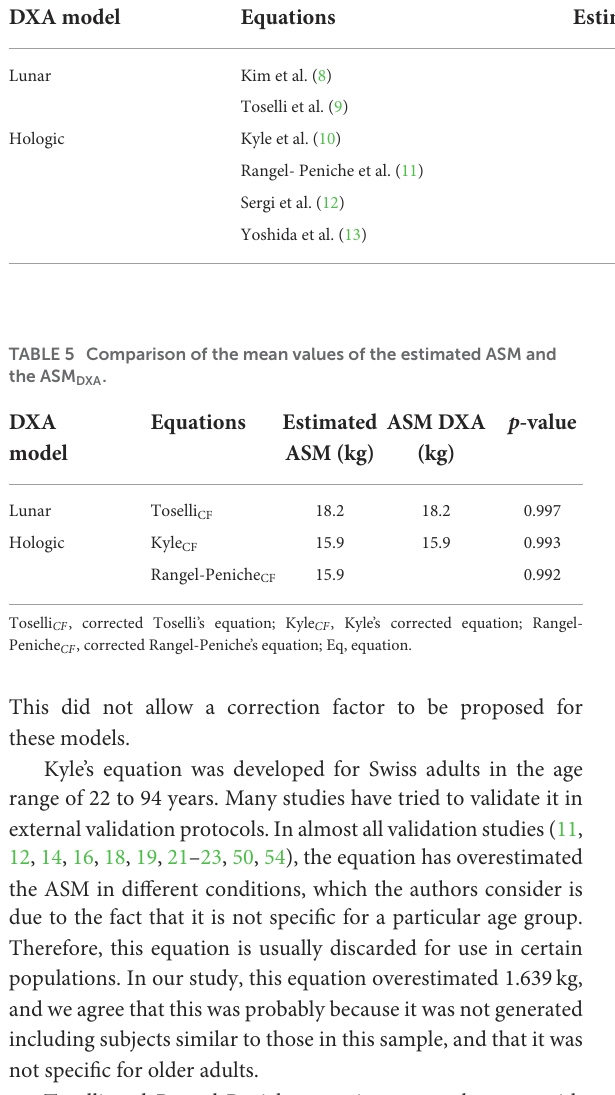
TABLE 4 Comparison of the mean values of the estimated ASM and the ASM DXA